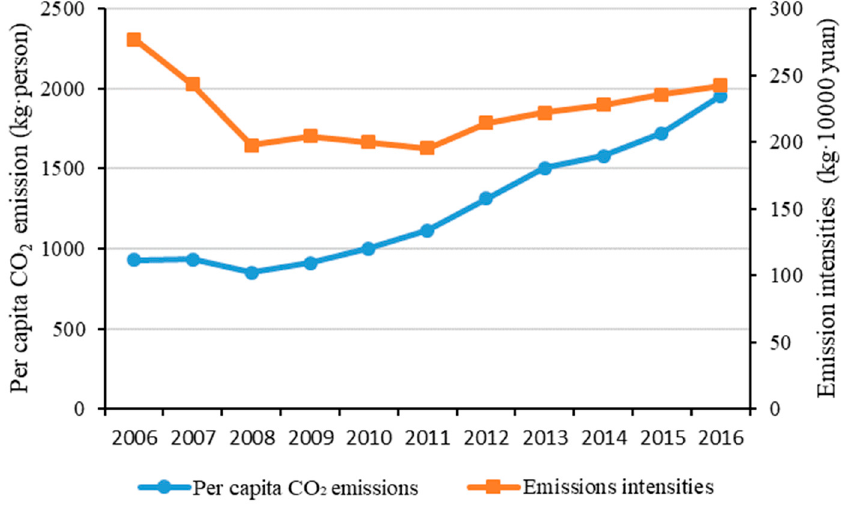
Figure 8. The per capita CO 2 emissions and emissions intensities of the Pearl River Delta, 2006 –